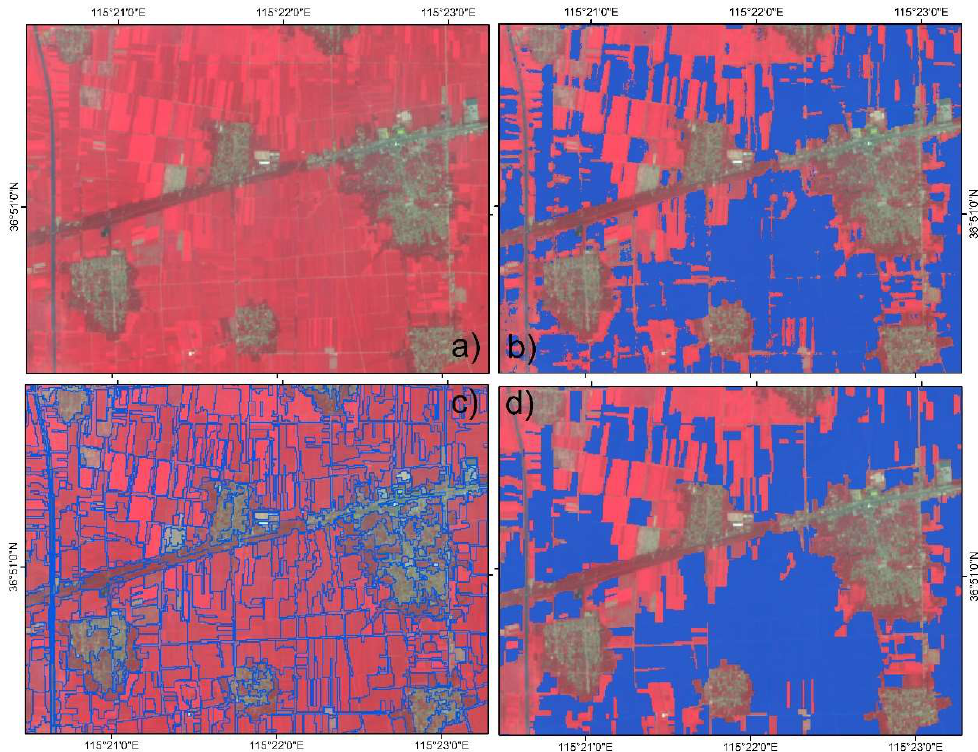
Figure 7. Part of the output images of object segmentation and integration with pixel-based results: ( a ) false-color combination with near infrared (NIR), red, and green in the R, G, and B channels, respectively; ( b ) pixel-based result output from a random forest (RF) classifier; ( c ) object boundary generated with multiresolution segmentation; and ( d ) integration with pixel-based results and object-oriented segmentation.